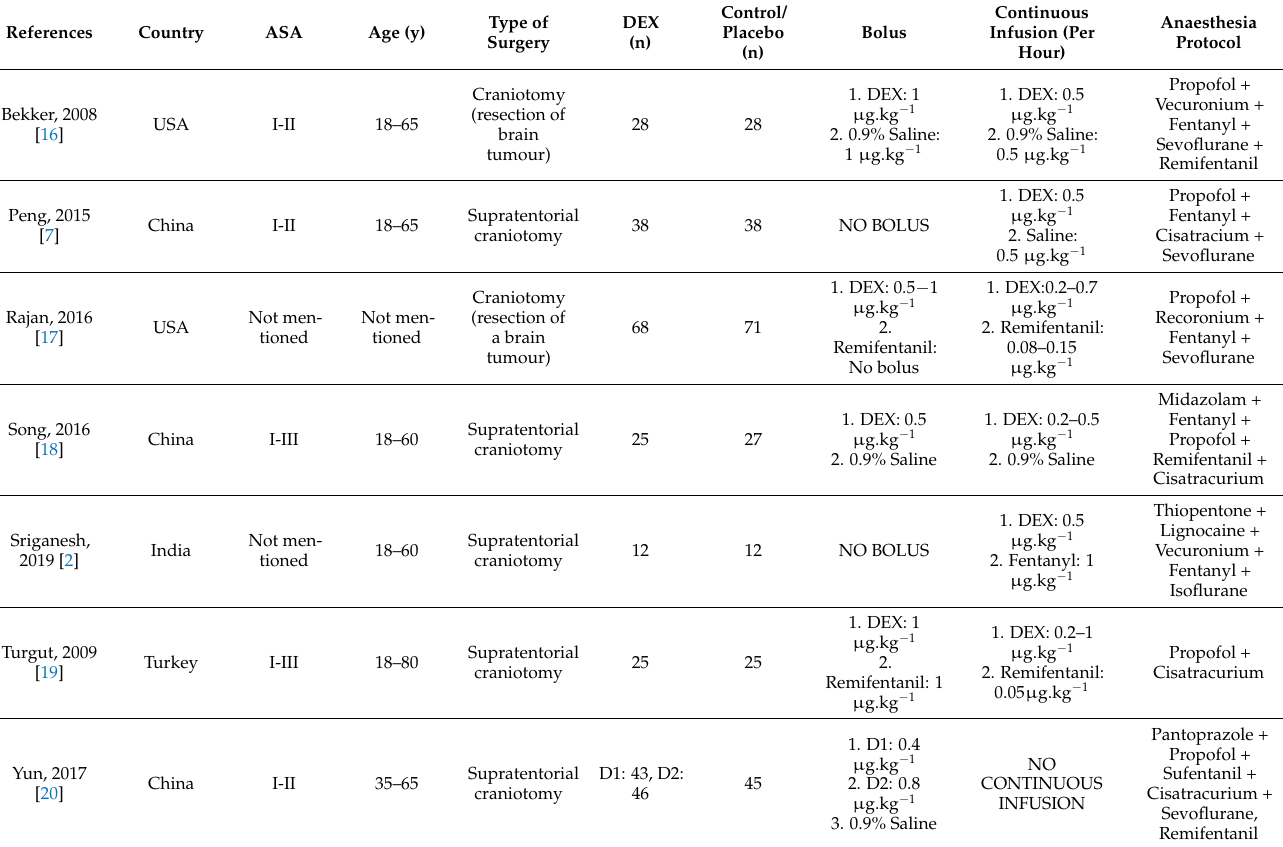
Table 1. Characteristics of patients receiving dexmedetomidine or placebo in the included trials. Values are numbers